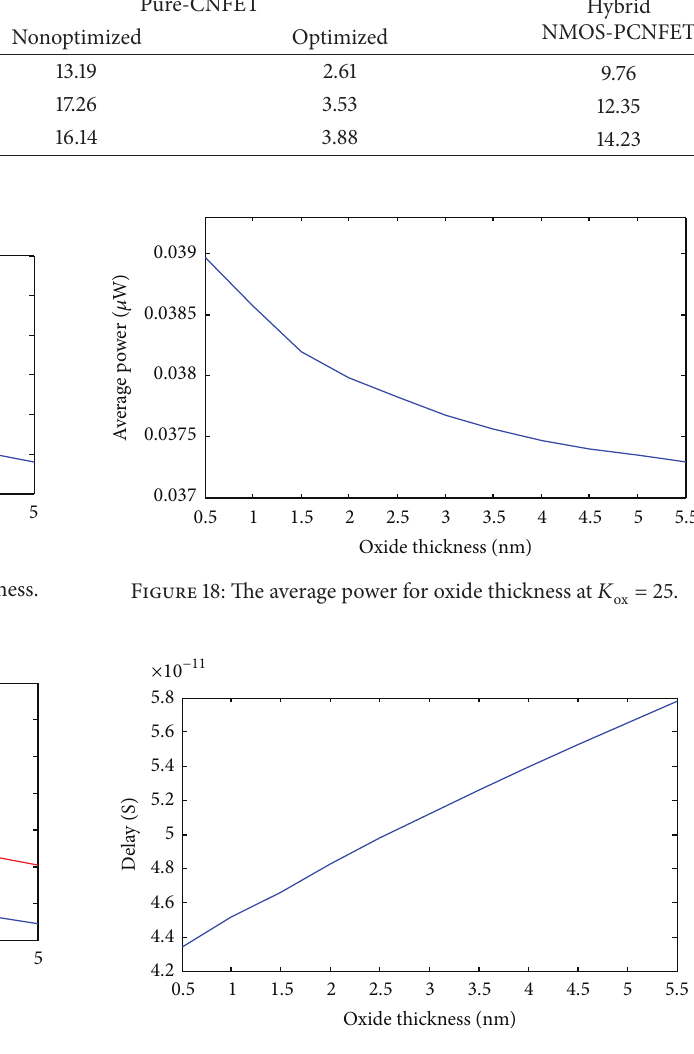
Figure 19: The delay for oxide thickness at 𝐾 ox =